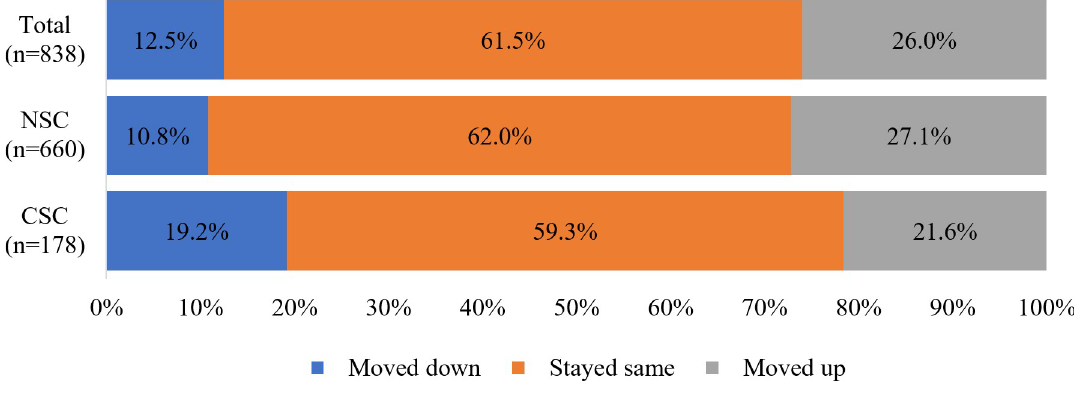
Fig 2. Poverty trajectory of households stratified by presence of child with surgical condition (n =